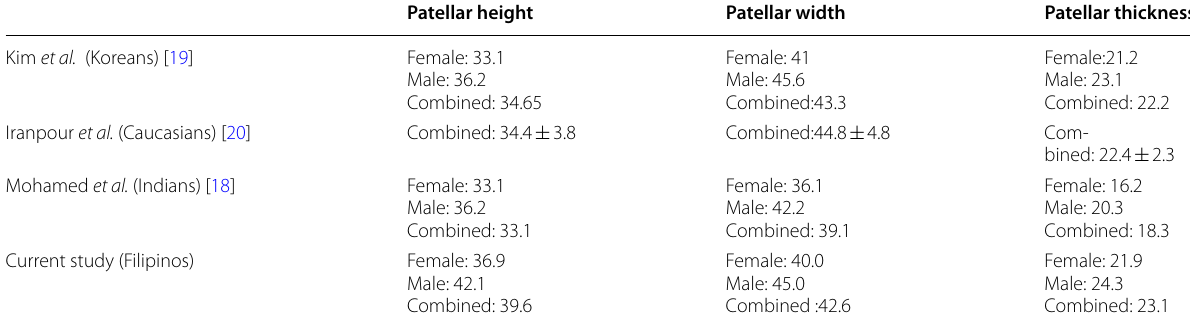
Table 10 Patellar dimensions of different ethnicities (in millimeters) Patellar height Patellar width Patellar